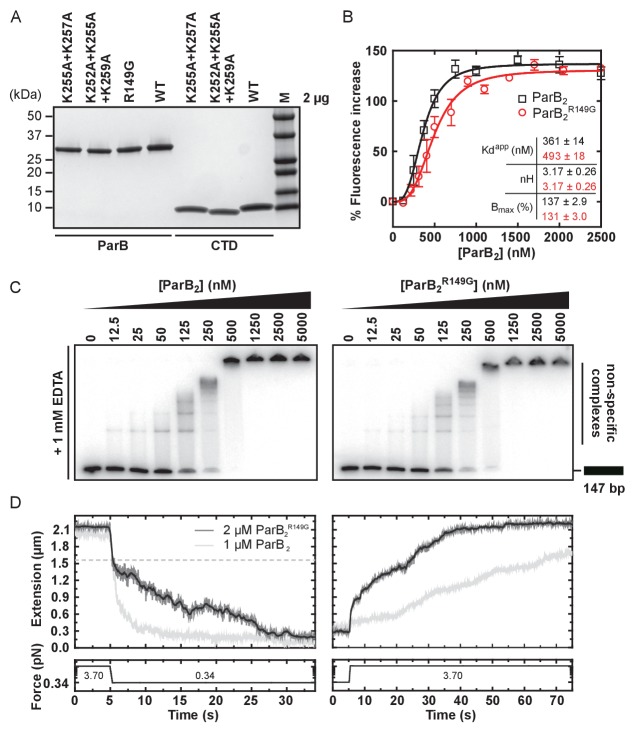
The R149 residue within the HtH motif is not required for non-specific binding and condensation.(A) SDS-PAGE of wild type ParB and mutant protein preparations. (B) Non-specific DNA binding isotherms for wild type ParB and ParBR149G measured using a PIFE assay. The data were fitted to the Hill equation. Error bars represent the standard errors from three independent experiments. Standard errors of fitted parameters were calculated in GraphPad Prism. (C) TBE-EMSAs for wild type ParB and ParBR149G binding 147 bp DNA. (D) Left panel: representative condensation traces for wild type ParB and ParBR149G, monitored by magnetic tweezers. At a 3.70 pN stretching force, ParB was introduced to single DNA tethers. Following incubation, force was reduced to 0.34 pN to induce condensation. Expected DNA extension under 0.34 pN and in the absence of ParB is indicated by the dashed line. Right panel: representative force-induced decondensation traces for wild type ParB and ParBR149G.